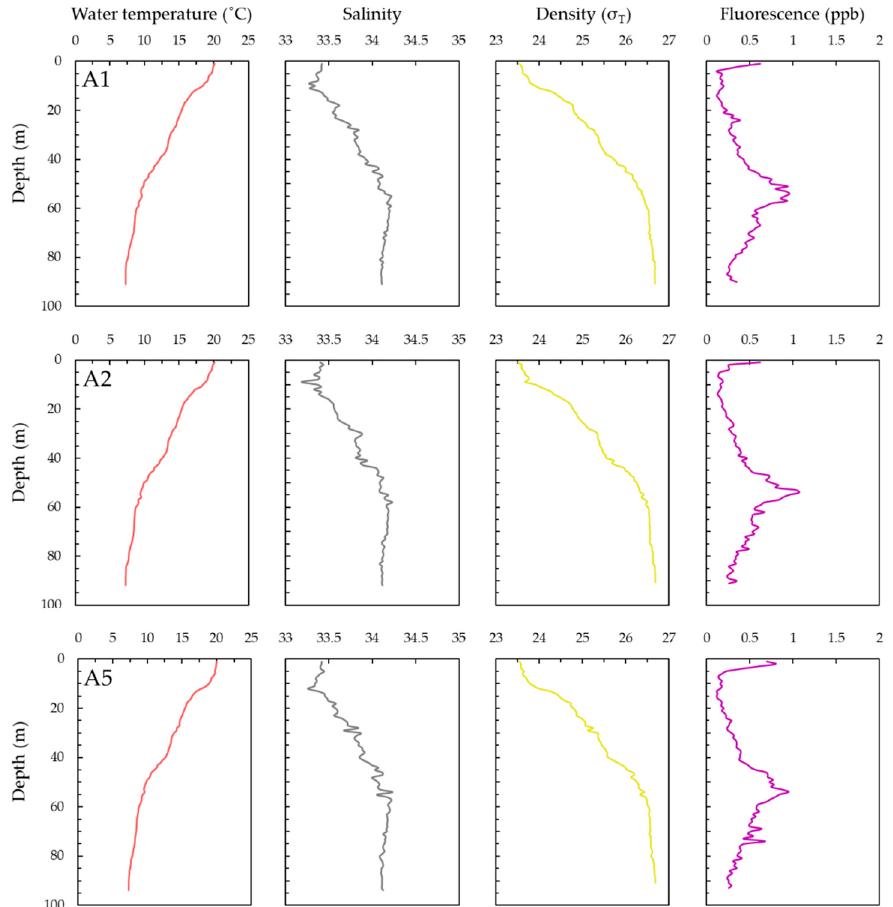
Figure 2. Vertical profiles of the environmental variables (water temperature, salinity, density ( σ T ), and chlorophyll fluorescence) at A1, A2, and A5.